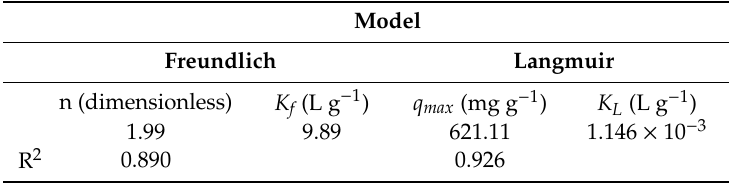
Table 4. Parameters of Langmuir and Freundlich isotherms for COD removal by electrochemical coagulation